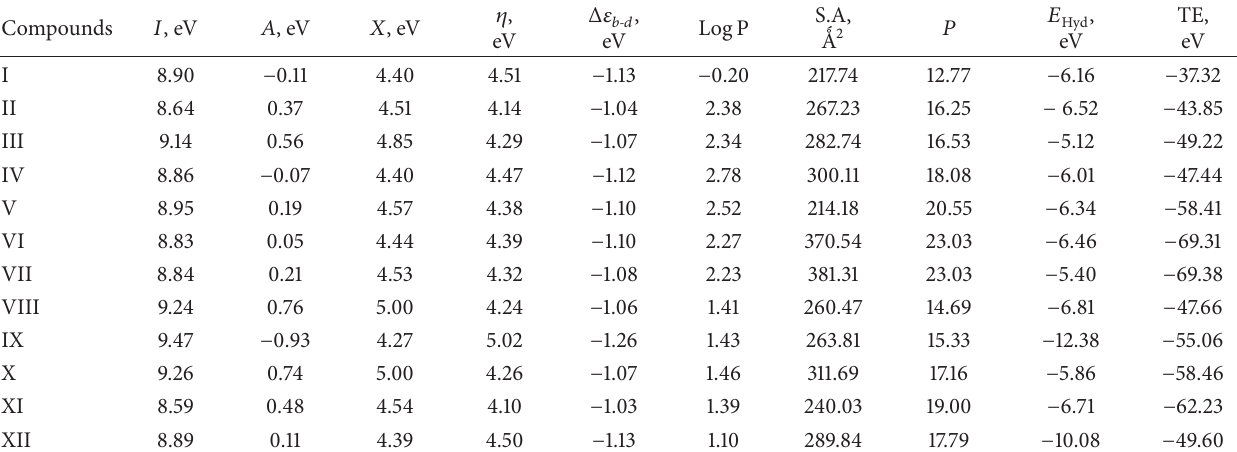
Table 3: The quantum chemical parameters and QSAR parameters for the investigated 1,3-benzodioxole derivatives using MNDO. Compounds 𝐼 ,